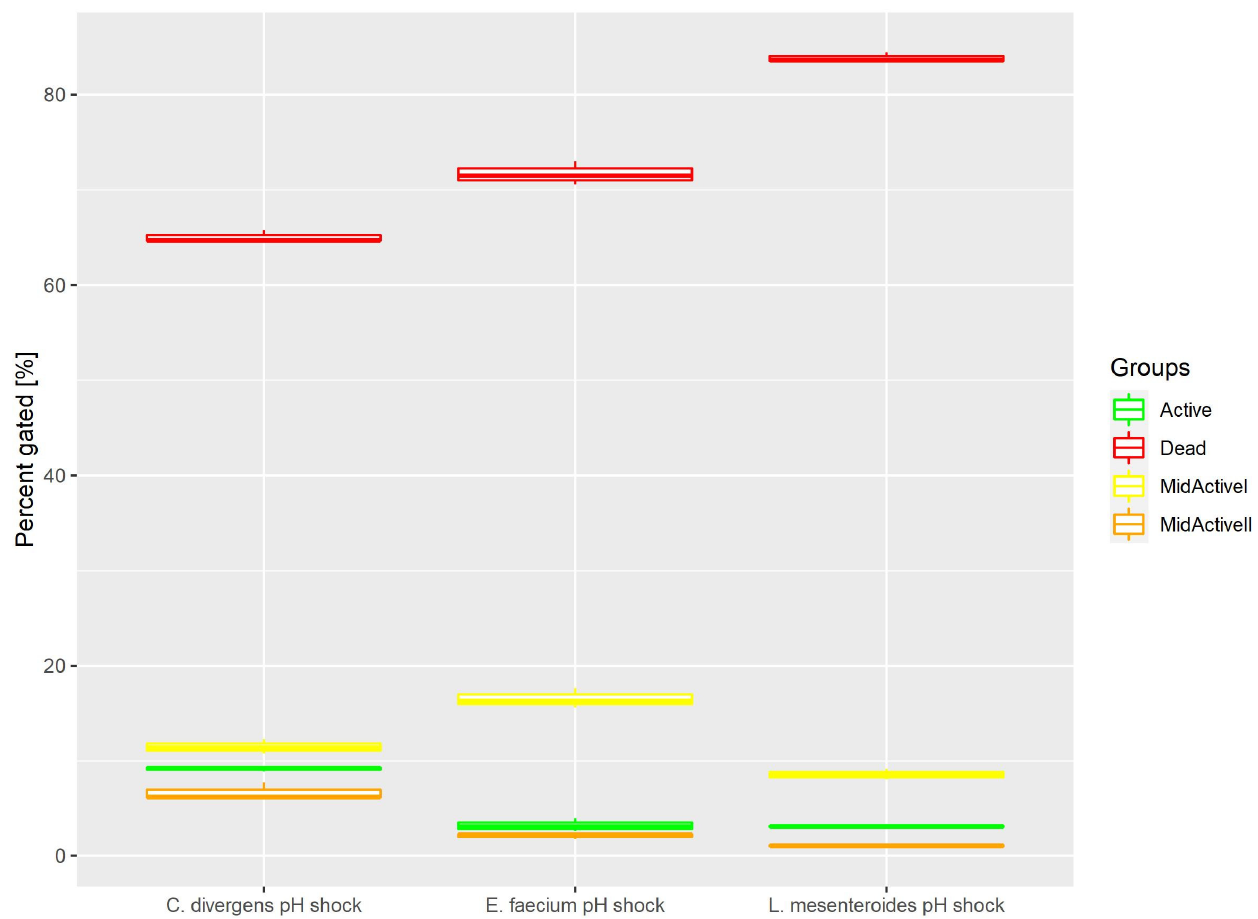
Figure 5. Cell subpopulation percentages in samples after pH shock. The distribution of cells between different groups was measured after exposing cells to pH 2.5 for 30 min.